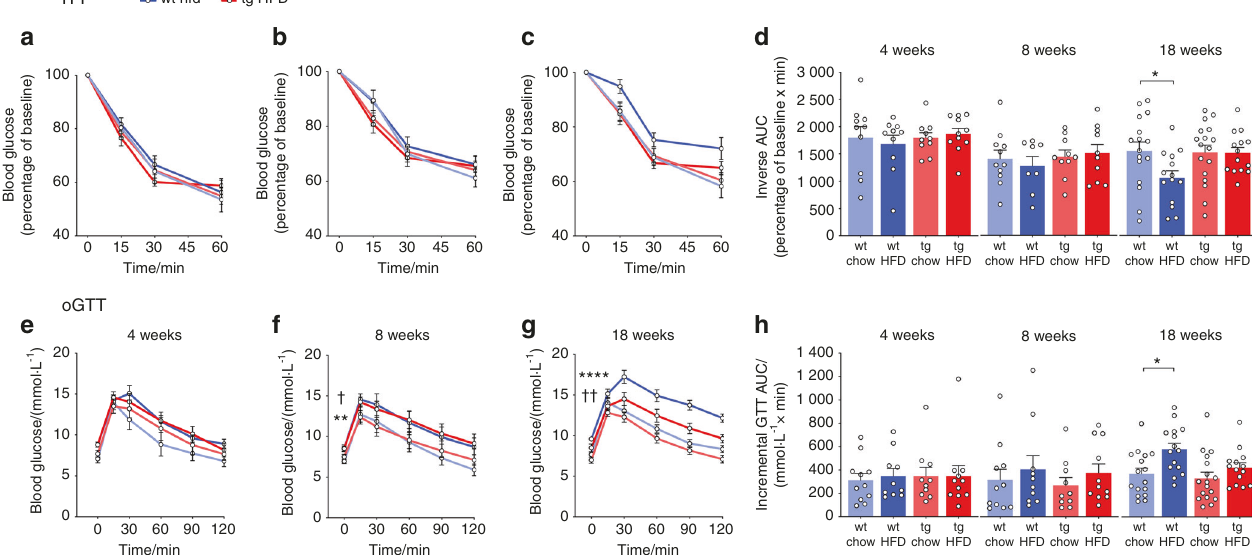
Fig. 6 HSD2 OB/OCY -tg mice were protected against HFD-induced insulin resistance and glucose intolerance. a – d Insulin tolerance test (ITT) results from wild-type chow, wild-type HFD, tg chow and tg HFD mice after 4, 8, and 18 weeks of feeding. Blood glucose concentrations are expressed as a percentage of basal levels and are shown as the mean ± SEM, n = 10 – 11/group. d Inverse area under the curve during the ITT at 4, 8, and 18 weeks. The results are shown as scatterplots, with the mean ± SEM shown in columns. Signi fi cance was determined using two-way ANOVA at each timepoint, with the Tukey ’ s multiple comparison test used for post hoc testing. * P < 0.05 for comparison. e – h Oral glucose tolerance test (oGTT) results after 4, 8, and 18 weeks of feeding, n = 14 – 17 for each group/timepoint. h Incremental area under the curve for the GTT at 4, 8, and 18 weeks. At 18 weeks, the effects of diet and genotype were both signi fi cant (diet: F 1,58 = 9.640, P = 0.002 9; genotype: F 1,58 = 4.139, P = 0.047). * P < 0.05, ** P < 0.01, and **** P < 0.000 1 for wild-type chow vs. wild-type HFD, † P < 0.05 and †† P < 0.01 for tg chow vs. tg